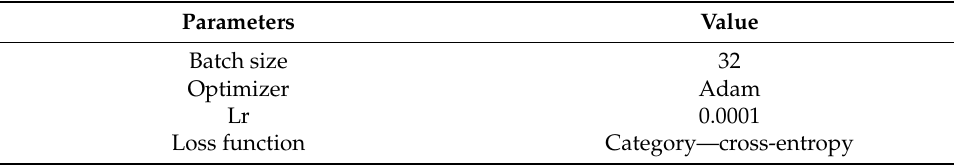
Figure 4. Architecture of the proposed MTF-ResNet model. Table 2. Detailed parameters of the MTF-ResNet